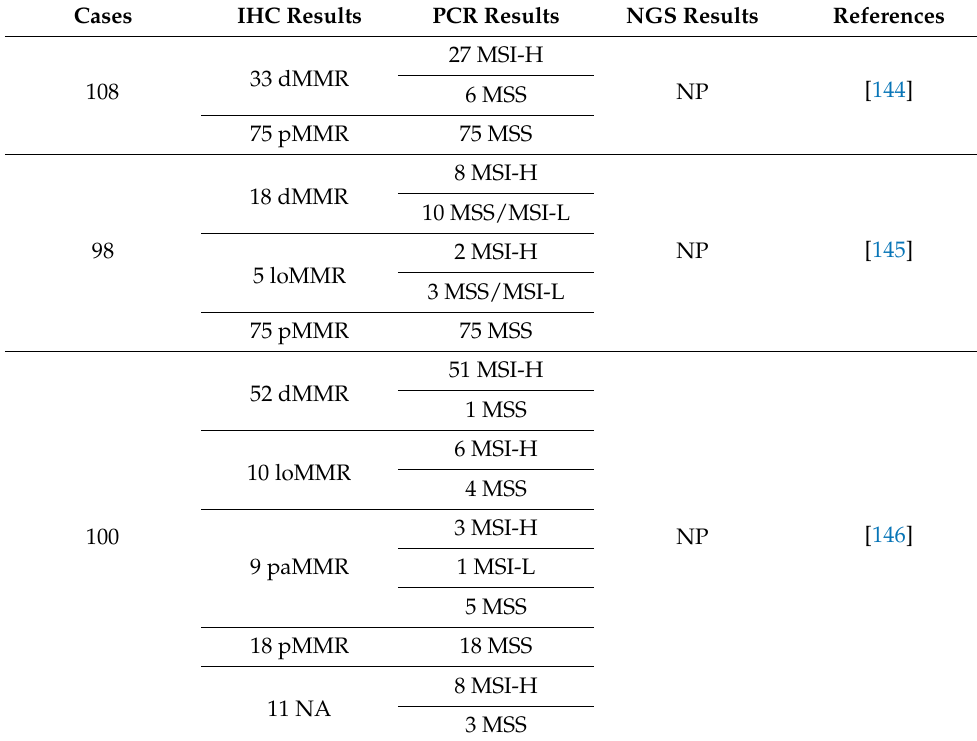
Table 8. Comparison between IHC, PCR and NGS in EC